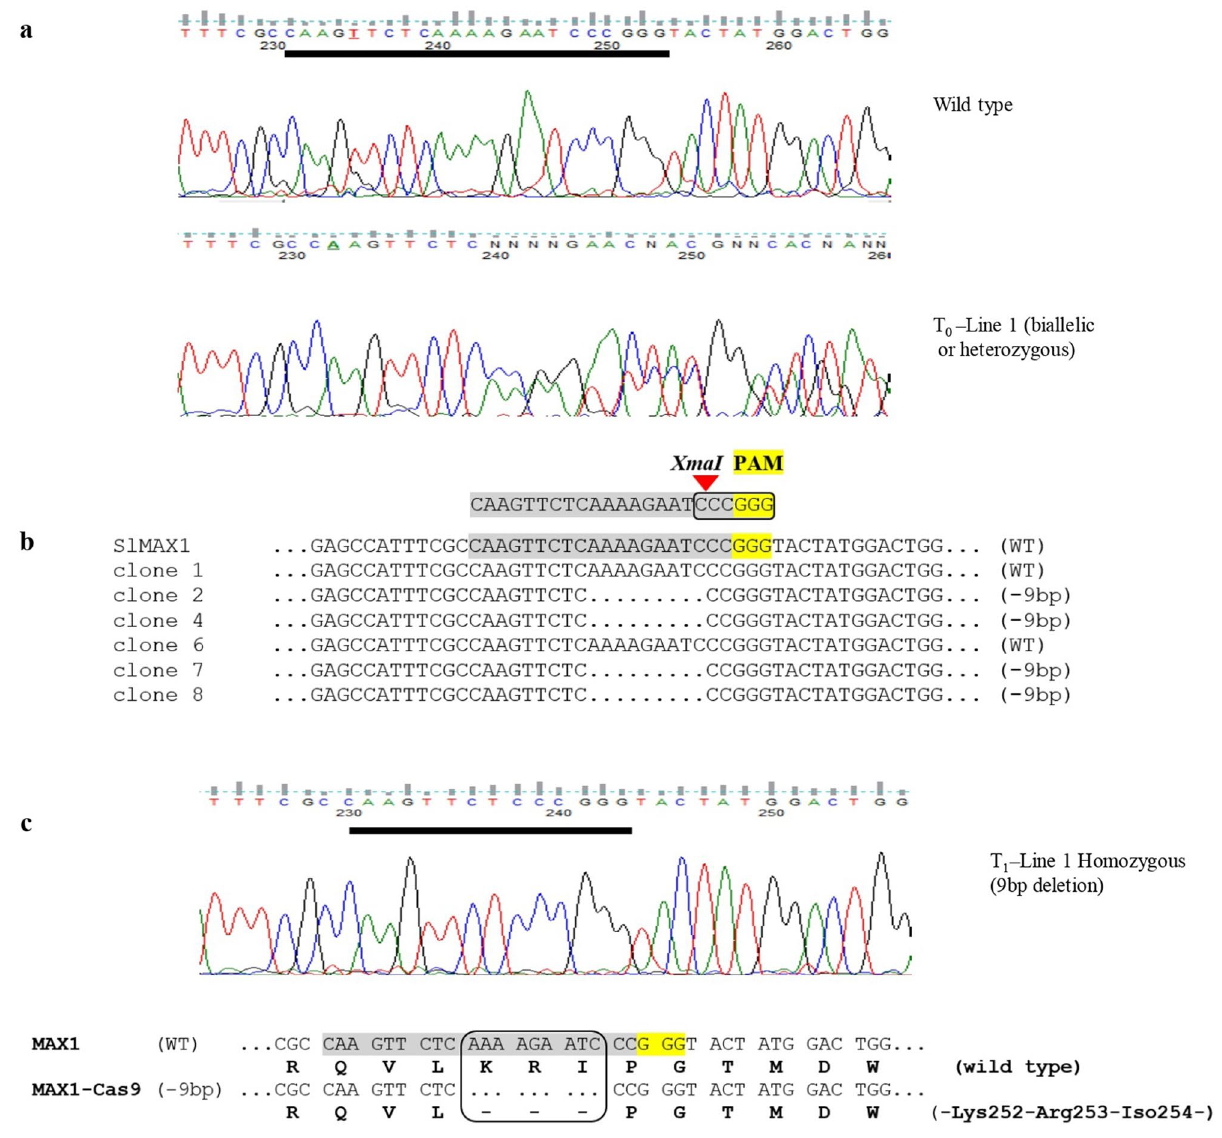
Figure 2. Identification of targeted editing events induced by CRISPR/Cas9 ( a ) DNA sequence chromatogram of MAX1-Cas9 targeted region, PCR product in the T 0 lines shown multiple peaks. ( b ) PCR product sequence alignment of the MAX1-Cas9 T 0 lines after TA cloning with the wild-type sequences (WT), deletion sizes (nt) are marked on the right side. ( c ) PCR product sequence alignment of the MAX1-Cas9 T 1 homozygous lines which causes deletion of amino acid sequences (Lys252-Arg253-Iso254) from protein in mutated plant as compared to wild